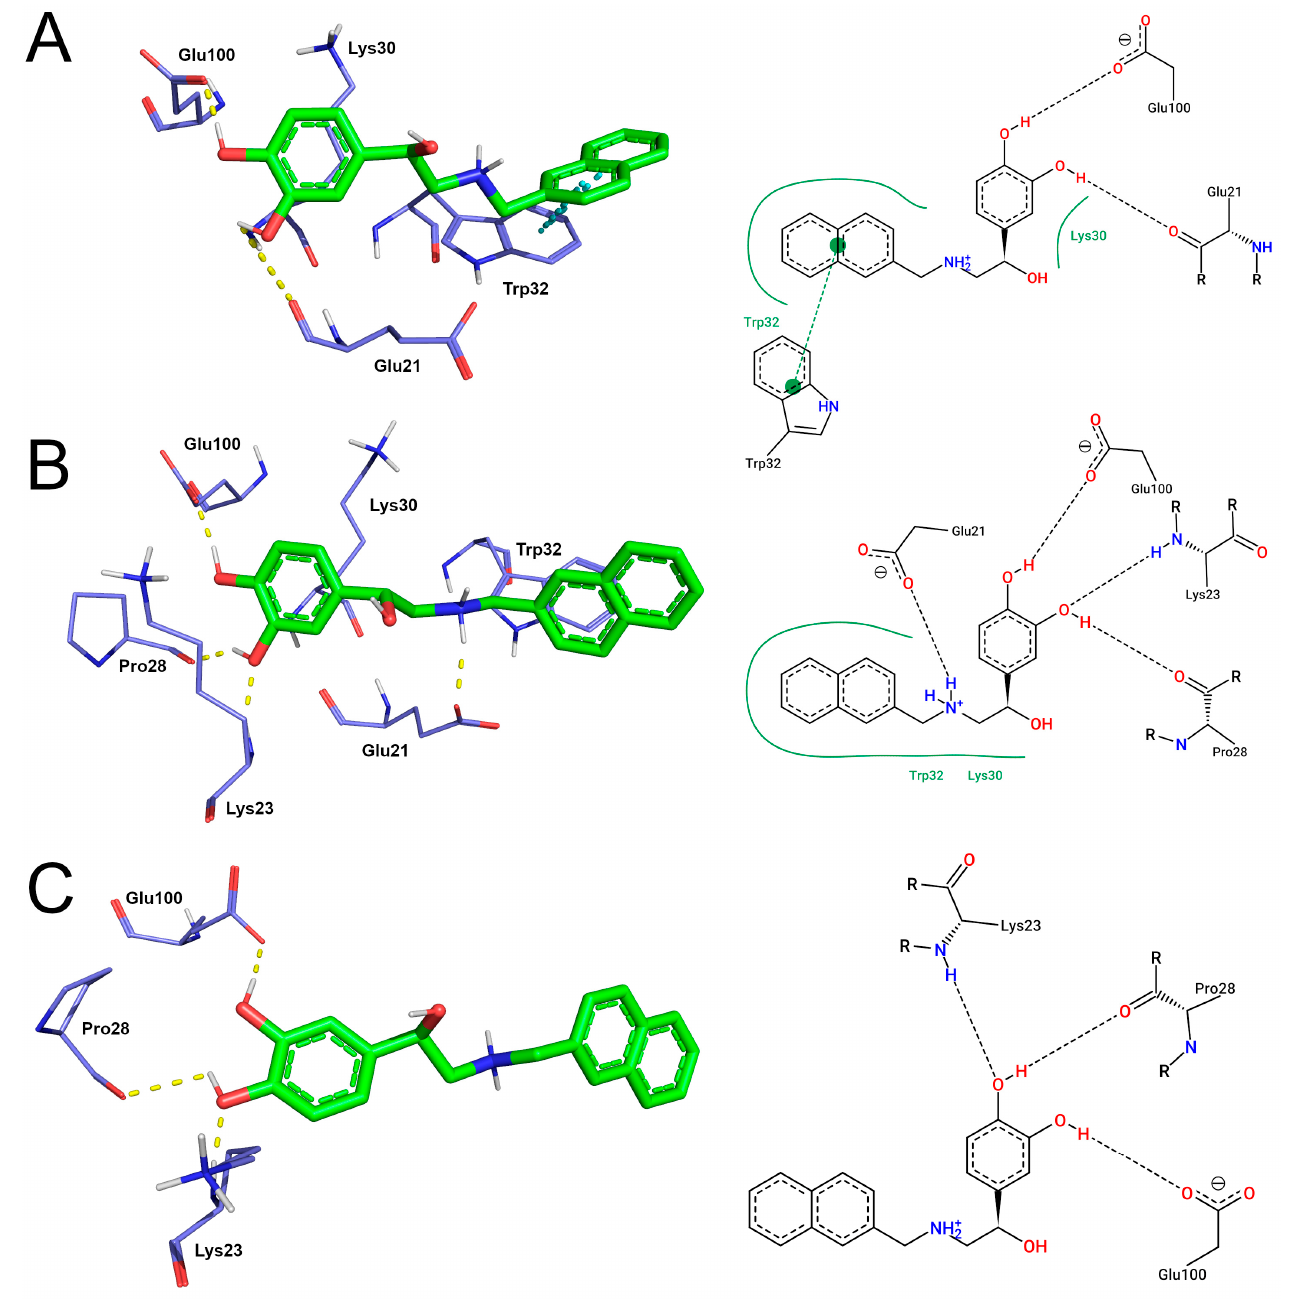
Figure 4. SOD1-SBL-1 binding modes observed in the representative structures extracted from the MD trajectories. Three-dimensional representations of SOD1-SBL-1 interactions were designed using Pymol software. SBL-1 molecule is represented by green sticks and colored by atom type. The interacting residues of SOD1 are represented by purple lines, colored by atom type, and labeled with the corresponding amino acid residue. Hydrogen bonds are represented by dashed yellow lines, while π -stacking is represented by dashed cyan lines. Residues involved in hydrophobic contact with SBL-1 are also shown. The bidimensional diagram of SOD1-SBL-1 interactions was designed using PoseView software. SBL-1 and interacting residues of SOD1 (labeled) are represented by black lines and colored by atom type. Hydrogen bond interactions are represented by dashed black lines, and hydrophobic contacts are represented by continuous green lines. ( A ) Wild-type; ( B ) variant A4V; ( C ) variant D90A.